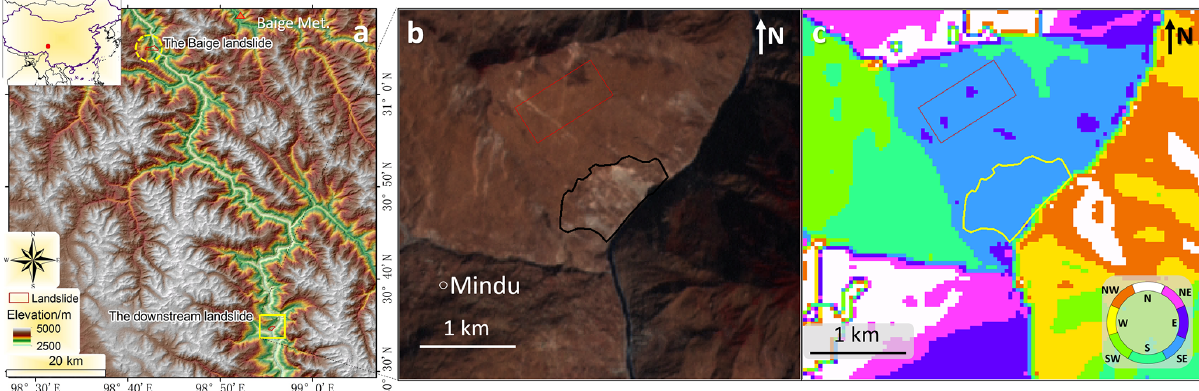
Figure 1. Topographic maps of the study area. (a) Geographic locations of the Baige landslide and the downstream landslide around the town of Mindu, Tibet Autonomous Region. (b) A 15m resolution pan-sharpened Landsat 7 false-colour image on 18 February 2001 and (c) aspect of the study area around the Mindu landslide. The elevation data in (a) are a product of NASA’s Shuttle Radar Topography Mission (SRTM), and the aspect in (c) is a derivative of the DEM. The red polygons in (b) and (c) are the selected stable zone. Both the SRTM DEM in (a) and its derivative (c) were downloaded from the Geospatial Data Cloud website (http://www.gscloud.cn/sources, last access: 22 November 2020). The Landsat image in (b) is a joint product of the United States Geological Survey and NASA and was downloaded via the Google Earth Engine (GEE).